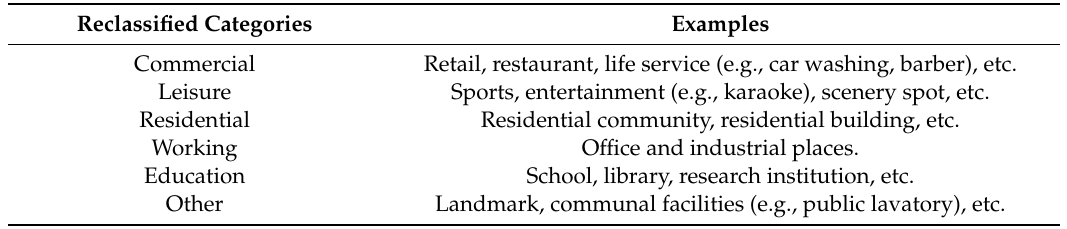
Figure 2. Maps showing the proportions of different land use types in Shenzhen as inferred from the aggregated POI check-ins; ( a ) Commercial, ( b ) Leisure, ( c ) Residential, ( d ) Working, ( e ) Education, ( f ) Other. Table 1. Reclassified point of interest (POI)